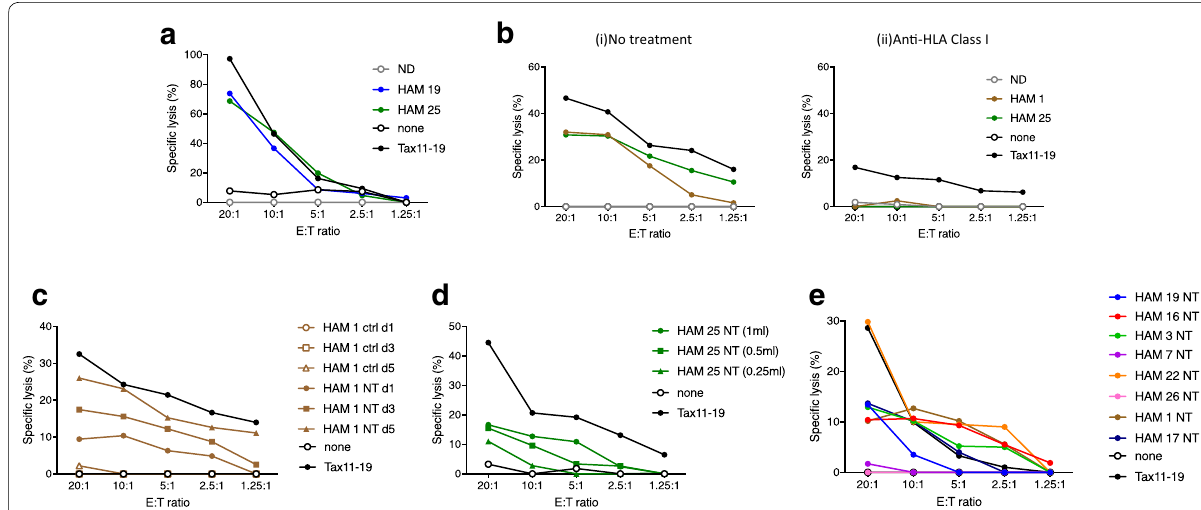
Fig. 6 HAM/TSP exosomes can sensitize targets to Ag‑specific responses. a Cytotoxic T lymphocyte (CTL) lysis was analyzed after the addition of HAM/TSP or ND PBMC‑derived exosomes or Tax11‑19 peptide. b HAM/TSP or ND PBMC‑derived exosomes or Tax11‑19 peptide pulsed targets were co‑cultured with anti‑HLA Class I ab (MCA81EL 5 μg/mL) and CTL target lysis was analyzed. c HAM/TSP PBMC supernatants were either nanotrapped with NT80 82 (NT) or with a control nanotrap (NT86) unable to isolate exosomes (ctrl). Supernatants collected after day 1, day 3, or + day 5 of culture were used for trapping. d Various amounts (1 mL, 500, and 250 μL) of 5 days HAM 25 PBMC tissue culture supernatants were used as the starting material for nanotrapping by NT80 82 particles (NT), followed by CTL assay. e Eight representative HAM/TSP patient PBMC‑derived + exosomes were utilized for additional analysis of CTL lysis by CTL